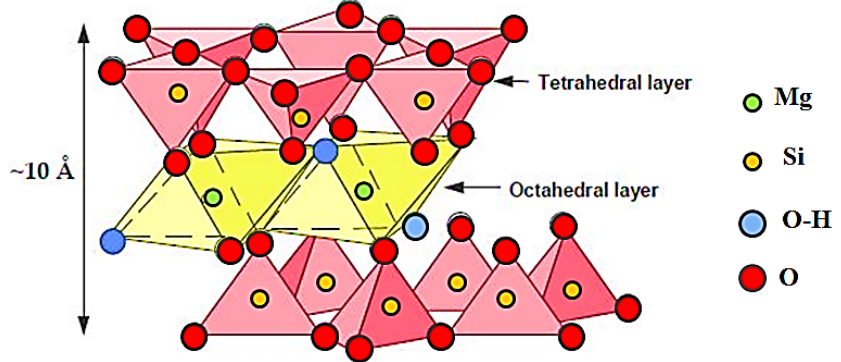
Figure 2. Schematic representation of the talc structures.